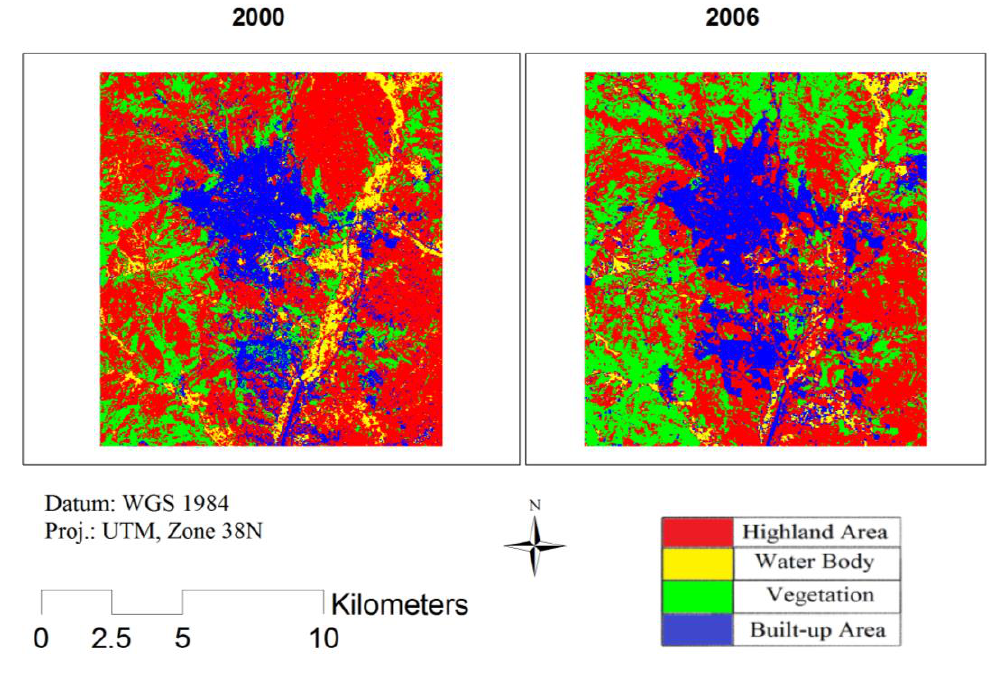
Fig. 1 A typical feed-forward back propagation